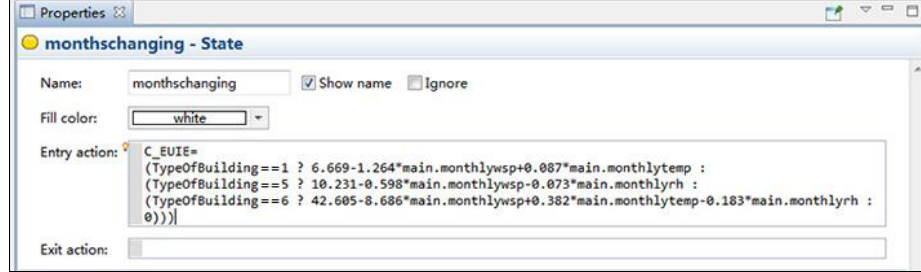
Figure 8. Calculation command under the climate sub-model of the building agent.